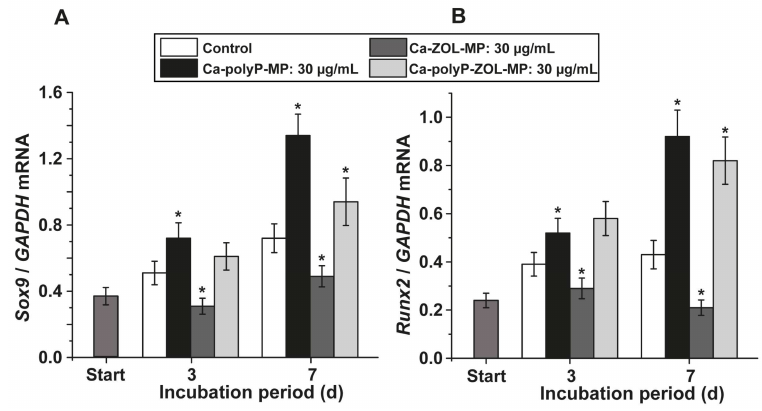
Figure 6. Effect of the compounds on the expression of osteogenic and chondrogenic differentiation markers in bone marrow cells. The cultures were supplemented with 30 µ g/mL of “Ca-polyP-MP”, “Ca-ZOL-MP”, or “Ca-polyP-ZOL-MP” on bone marrow cells in mouse femurs; in the controls the explants received no additional compound. The cells were incubated for 3 days or 7 days, then the RNA was isolated from the samples and the steady-state-expression of the transcripts of ( A ) Sox9 and ( B ) Runx2 was quantified by qRT-PCR and correlated to the expression of the GAPDH house-keeping gene. Standard errors of the means are shown ( n = 6 experiments per time point). The significant differences between the values in the controls and the respective treated samples are indicated with asterisks; * p < 0.01.